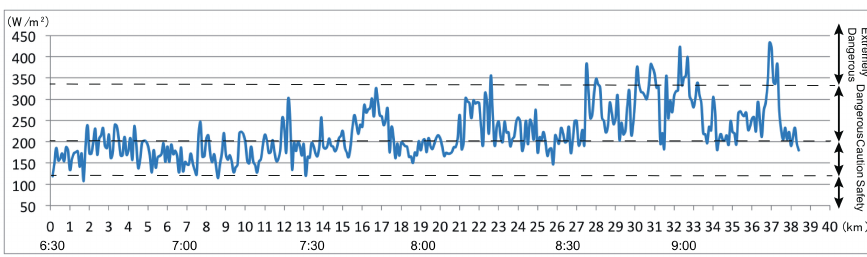
Figure 10. Energy budget for August 25, 2016 graphed as a function of